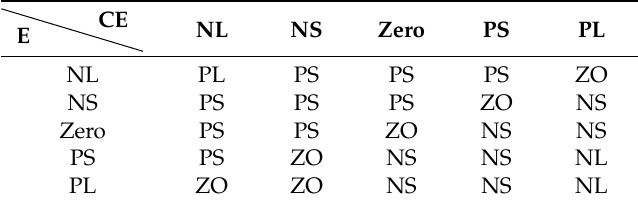
Table 2. The fuzzy rule of ∆(cid:1837) (cid:3036) .